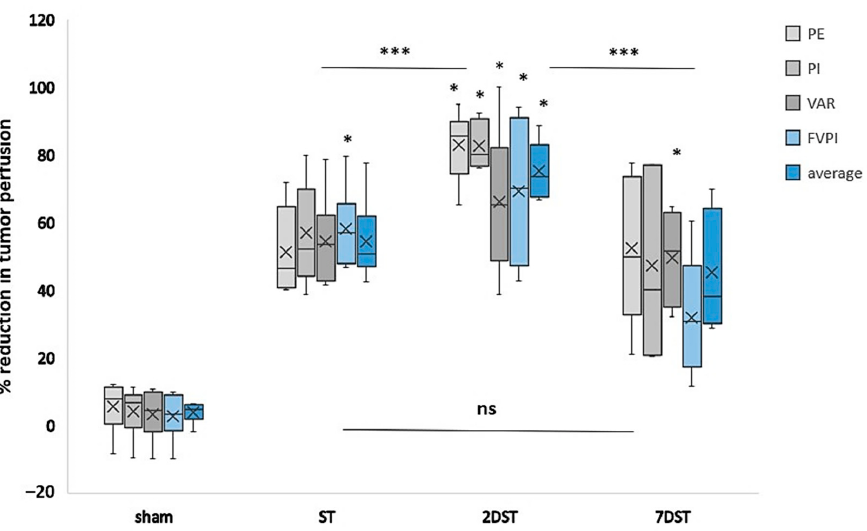
Figure 5. Box plot comparing the percentage reduction in tumor perfusion of single therapy (ST), subsequent therapies within two days (2DST), subsequent therapies with 7 days (7DST) and sham groups. Clearly, the 2DST group outperforms the other groups, showing a larger percentage decrease PE; peak enhancement, PI; perfusion index, VAR; vascularity area, FVPI; flow volume perfusion index, and, average represents the average of all parameters. * refers to significant percentage reduction ( p < 0.05). *** refers to significant difference between groups ( p < 0.001), and (ns) refers to